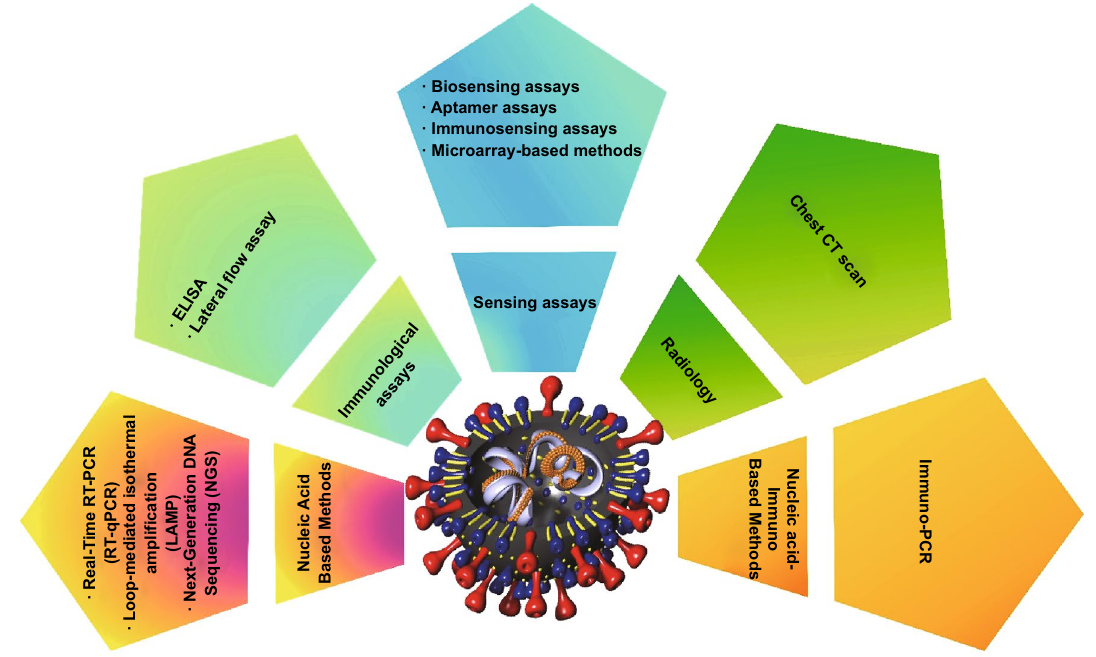
Fig. 4 Overview of different developed techniques for the detection of